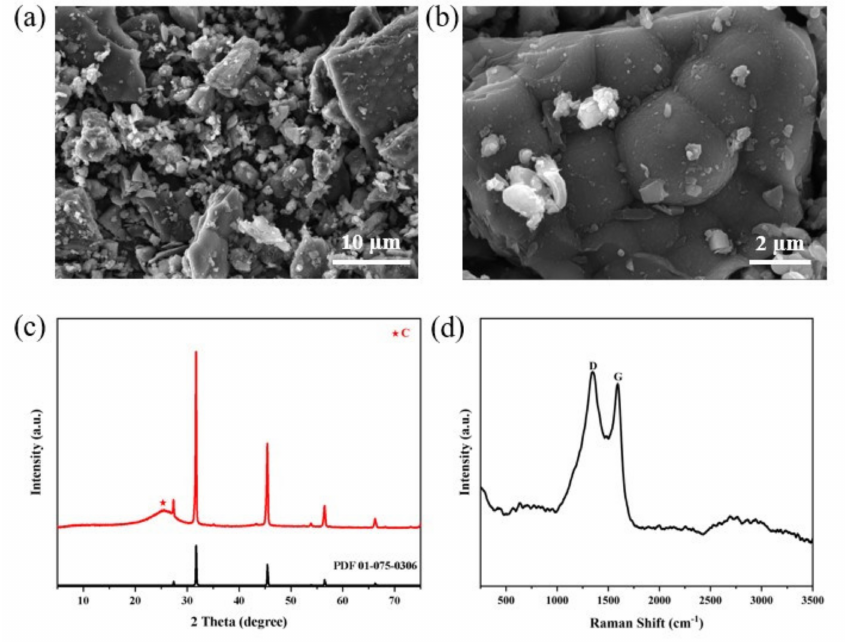
Figure 5. ( a , b ) SEM images of the carbon product; ( c ) X-ray diffraction pattern of the carbon product; and ( d ) Raman spectra of the carbon